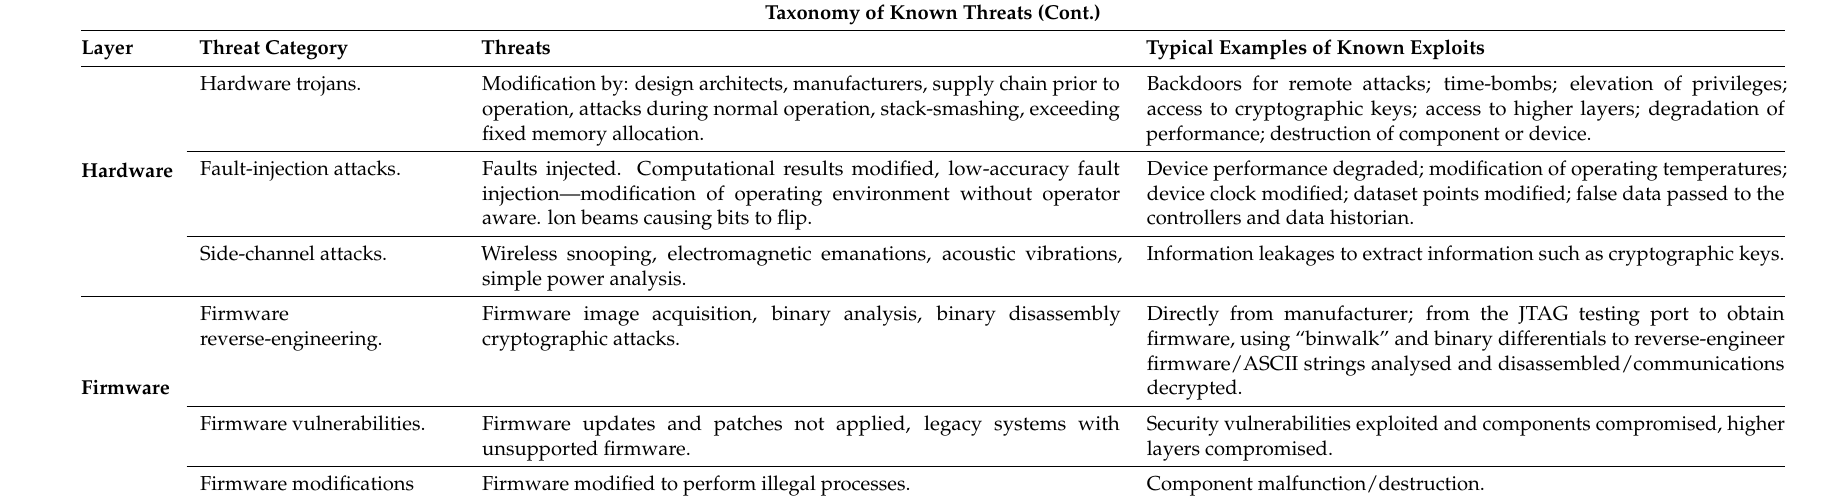
Table 2. Taxonomy of known threats (Cont.). Taxonomy of Known Threats